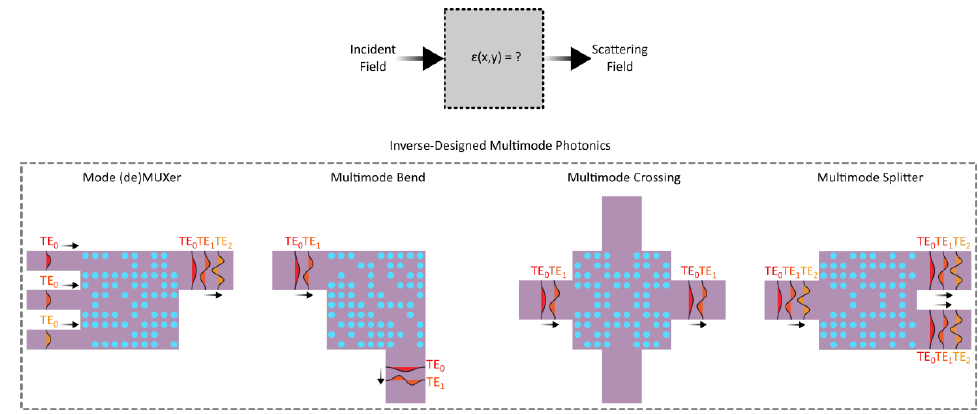
Figure 18. Upper panel: the schematic for photonic inverse-design. Lower panel: the schematic for inverse-designed mode (de)multiplexer [85], multi-mode bend [175], multi-mode crossing [204] and multi-mode splitter [220].